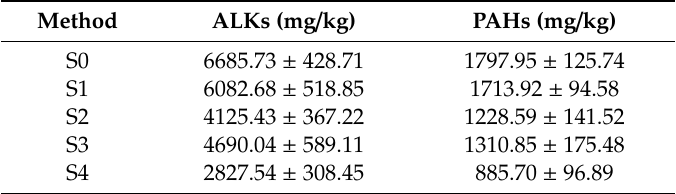
Table 3. Residual content of PHs in di ff erent remediation